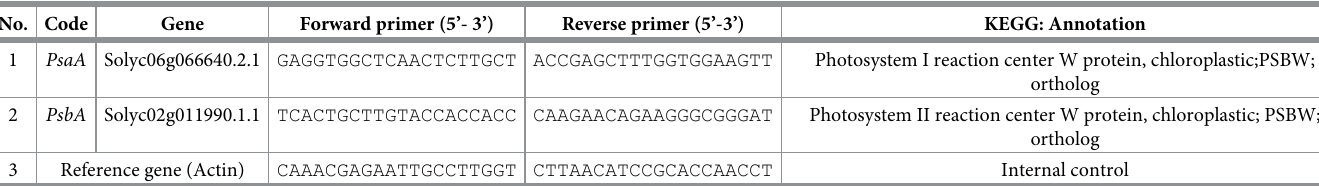
Table 2. The primer sequences of ( PsaA and PsbA ) and internal control gene (actin). No. Code